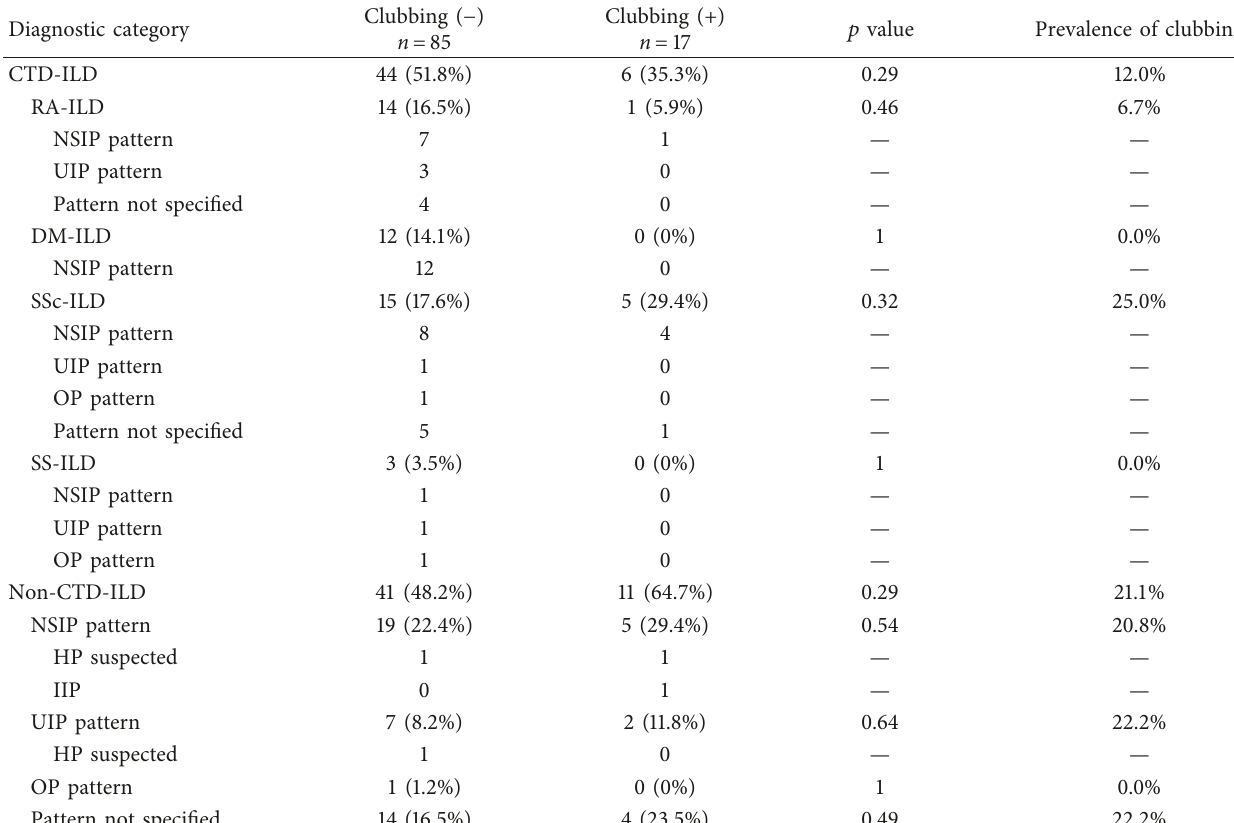
Table 2: Diagnostic category of